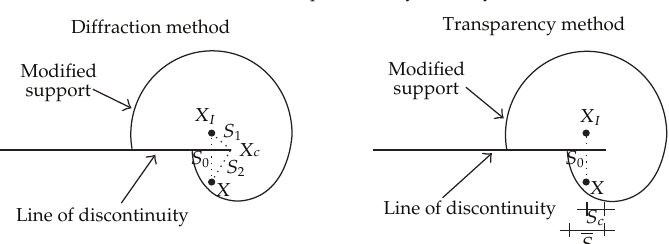
In (cid:6) 15 (cid:7) the transparency method is introduced. Here, the function is smoothed